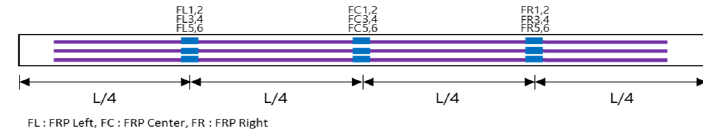
Figure 7. Lower concrete and inner tendon gauge positions (NSM and EP methods).